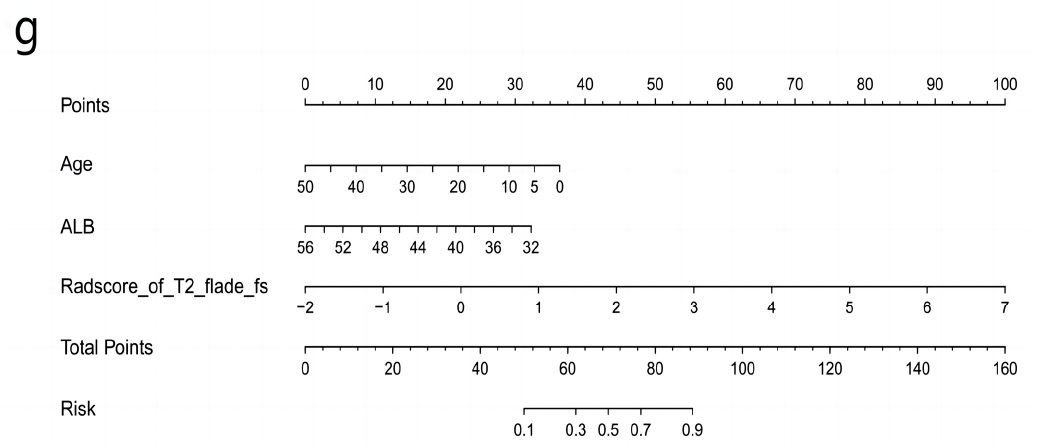
Figure 4. The best omics features of different image omics models are as follows: T2